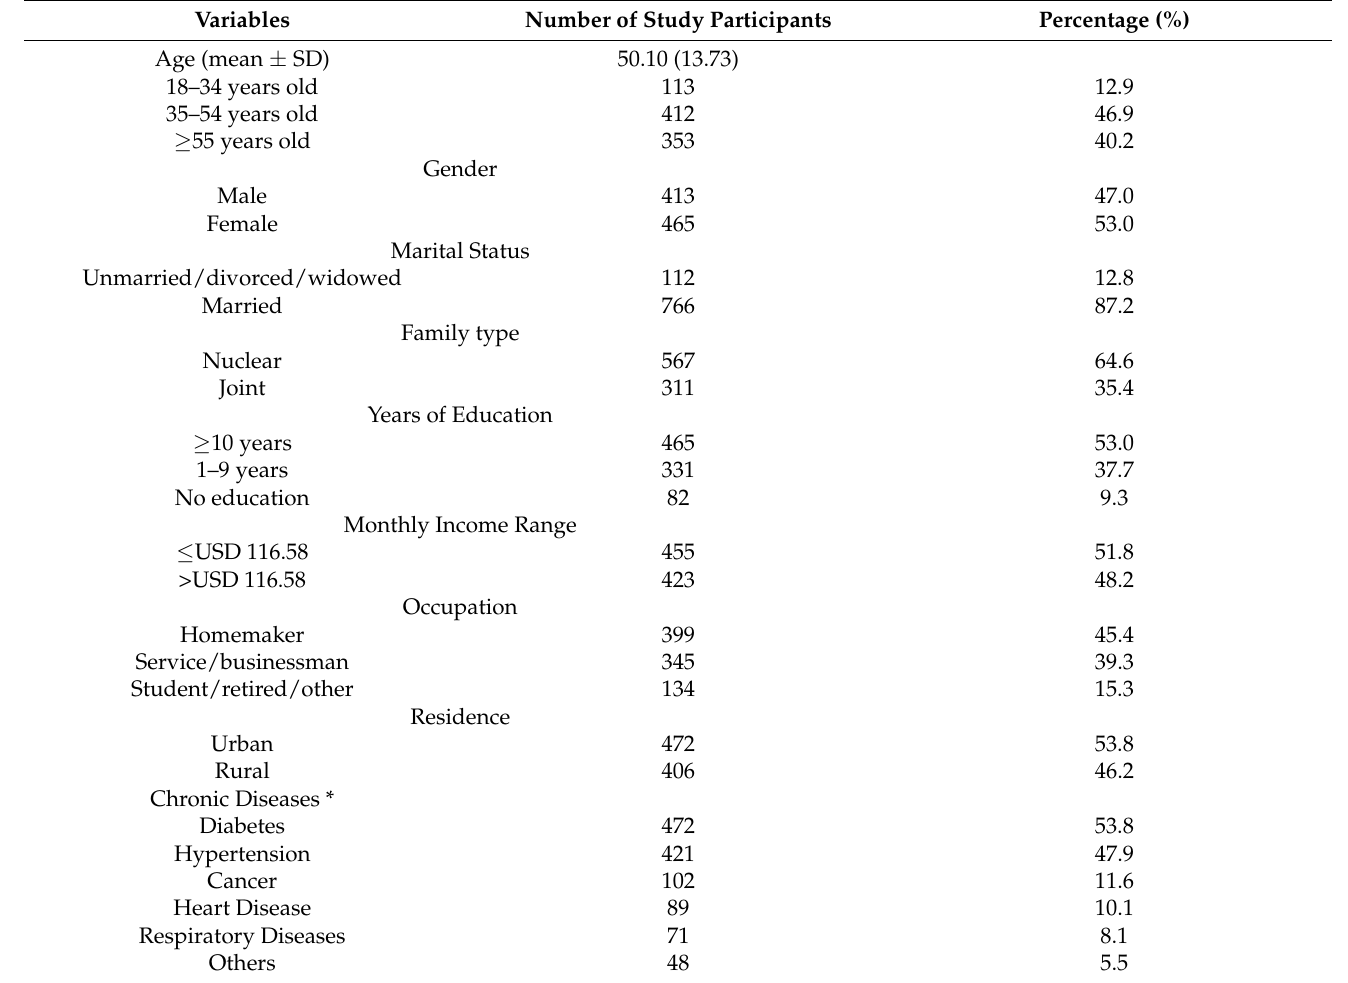
Table 1. Sociodemographic information of the study participants (N = 878).